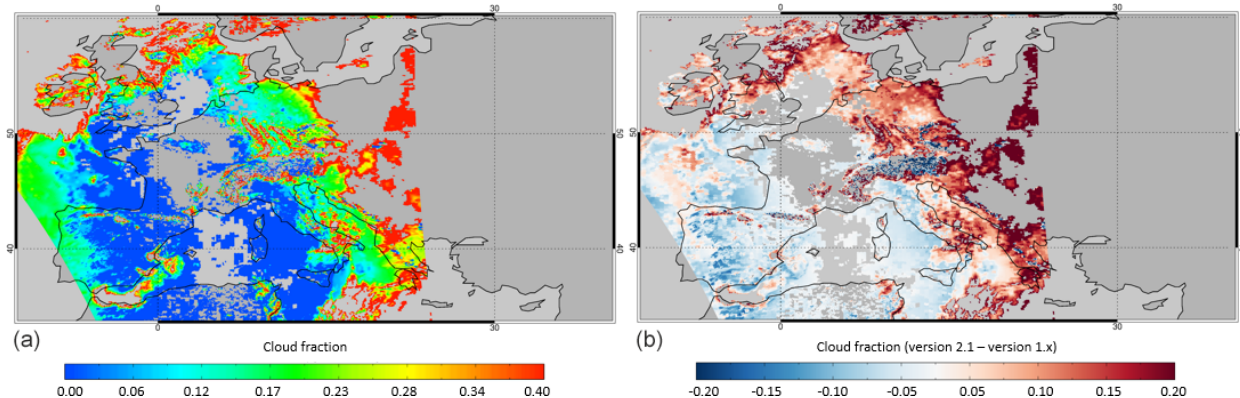
Figure 12. OCRA cloud fractions from the version 2.1 processor (left) and comparisons with version 1.x (right) over Europe for orbit 6939 on 14 February 2019. Only measurements with 0 < cloud fraction < = 0 . 4 are included.